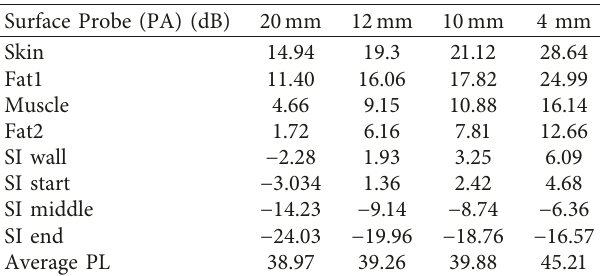
Table 10: Path loss values at 4GHz using probes in dB for PA at different distances d .